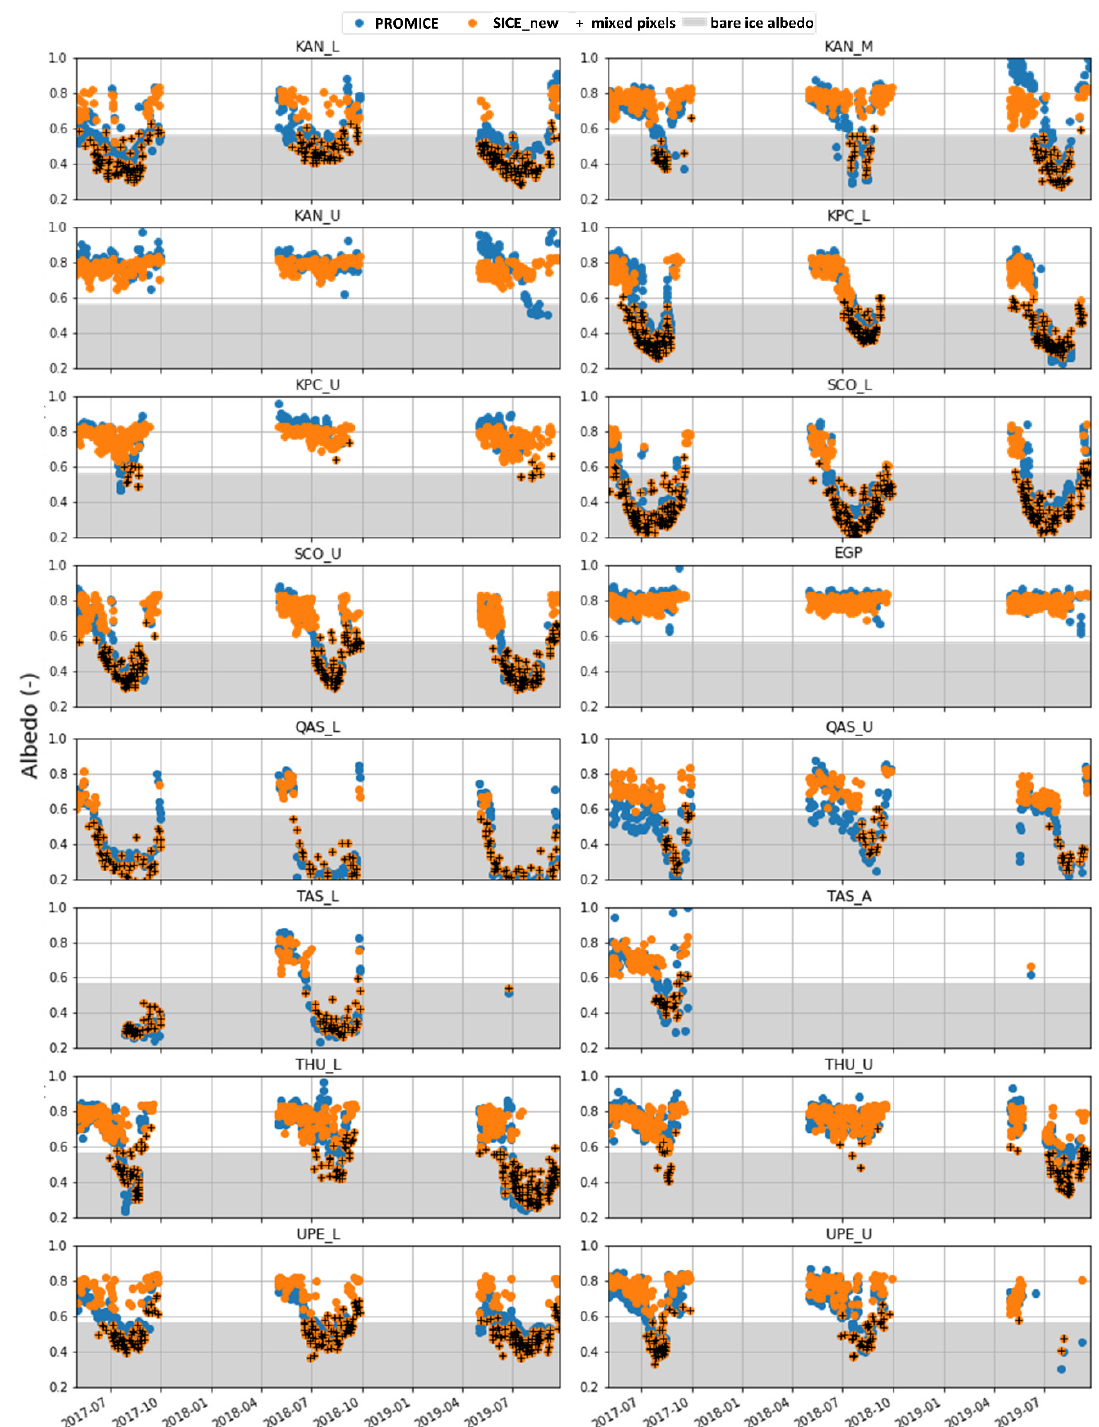
Figure 6. The time series of broadband albedo retrieved using OLCI measurements (new SICE algorithm) and measured by the PROMICE network. Mixed pixels correspond to the retrievals, where snow is mixed with other surfaces, including meltwater ponds and streams.